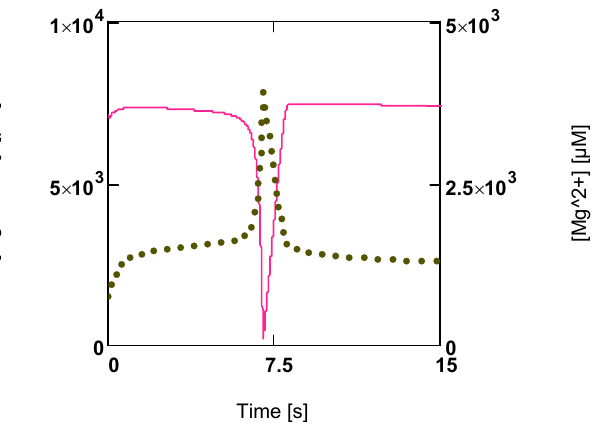
Figure 6. Time courses of [MgATP 2 − ] and [Mg 2+ ] during development of fatigue. (red line) [MgATP 2 − ]; (green points) [Mg 2+